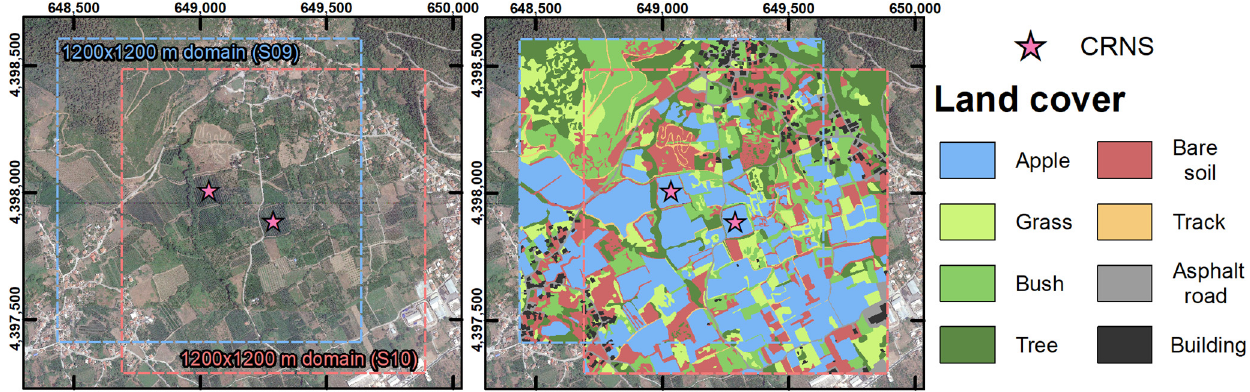
Figure 7. In the left panel: satellite image [75] with the extent of the simulated domains for fields S09 and S10. In the right panel: land cover with 1 m resolution for the investigated areas.